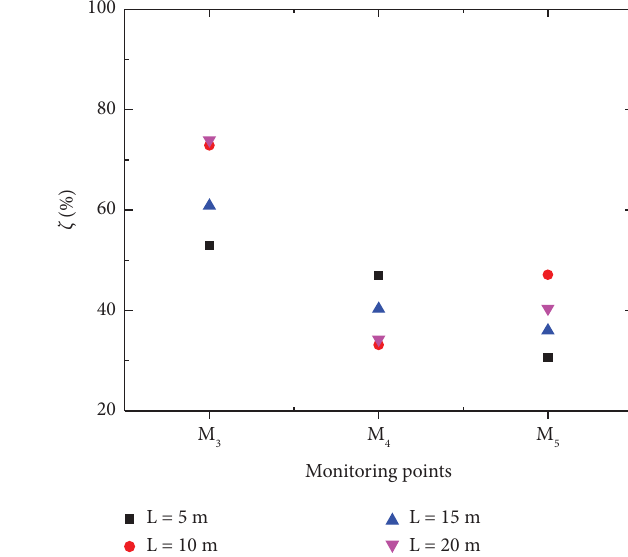
Figure 9: Attenuation coefcient of blasting vibration wave of blasting with a vibration-isolating slot with diferent